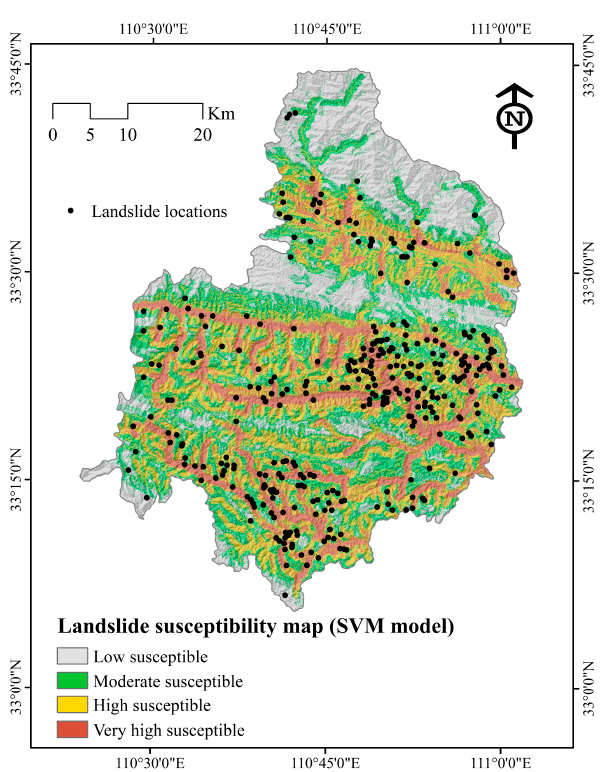
Figure 6. Landslide susceptibility map using the kernel logistic regression (KLR) model.